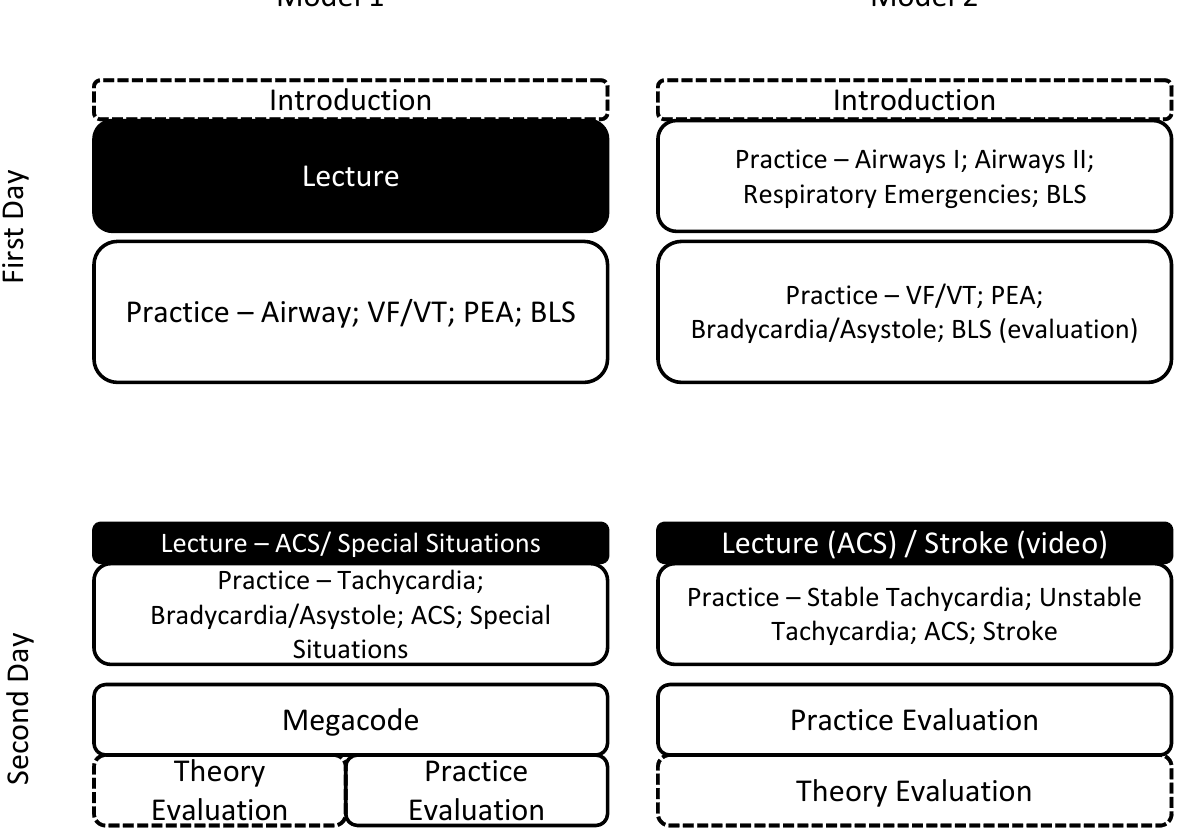
Figure 1. Schematic representation of the course models. The dotted lines represent administrative activities, the full-line blank boxes represent practice sessions and the black boxes theoretical sessions. VF/VT, PEA, Bradycardia/Asystole and ACS and BLS were kept from Model 1 to Model 2. VF/VT = ventricular fibrillation/pulseless ventricular tachycardia; PEA = pulseless electrical activity; BLS = basic life support; ACS = acute coronary